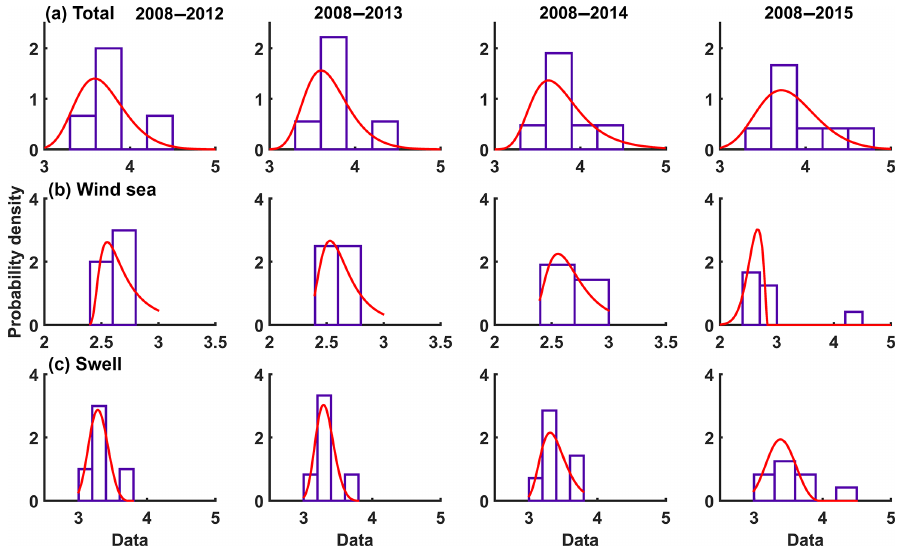
Figure 9. Density plots showing the probability for different wave height class. Total, wind-sea and swell H s are presented row wise. Columns correspond to the selected number of data points (5 to 8 years). The solid curve is the corresponding GPD fit.